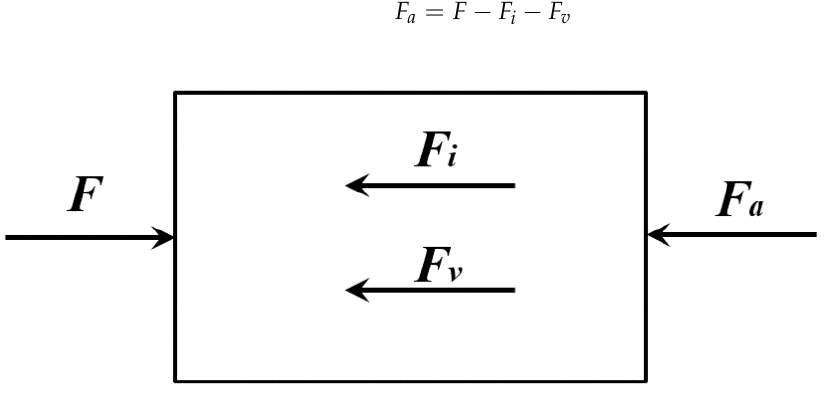
Figure 4. Schematic diagram of the force of the specimen.